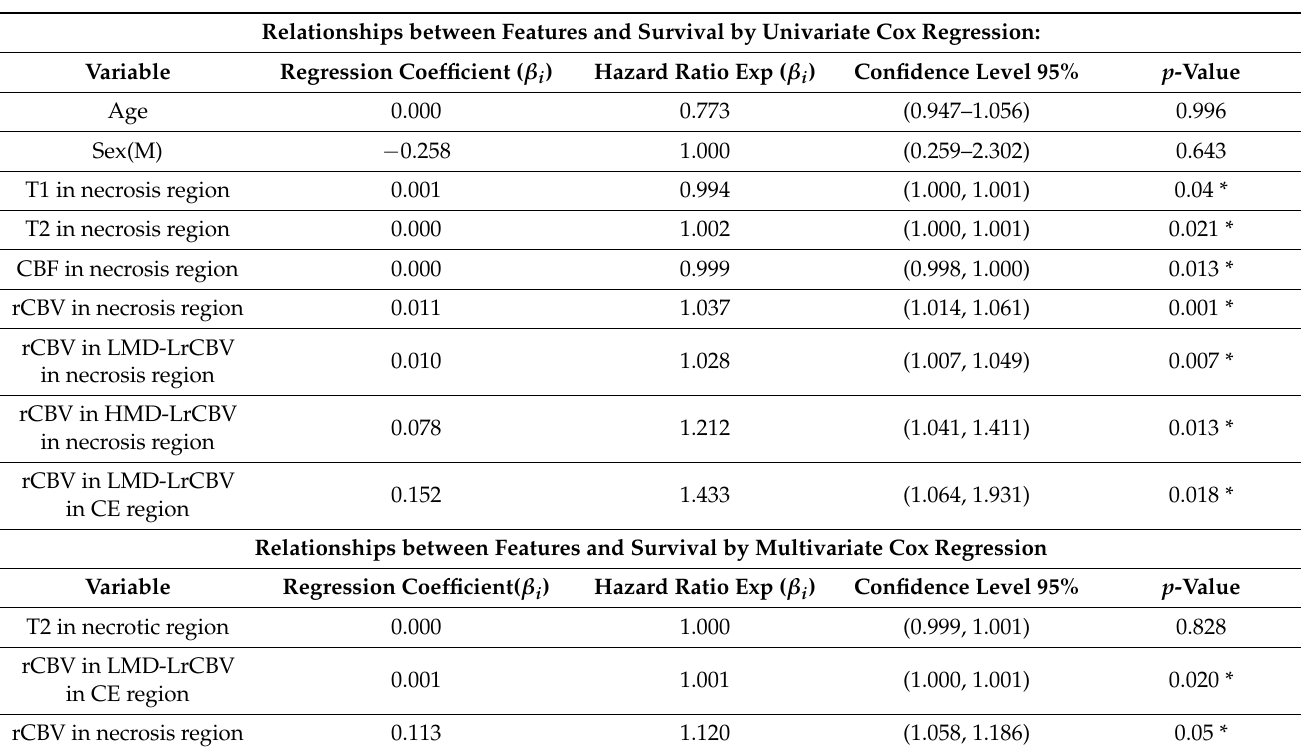
Table 2. Relationships between features and survival by univariate Cox regression and multivariate Cox regression. Relationships between Features and Survival by Univariate Cox